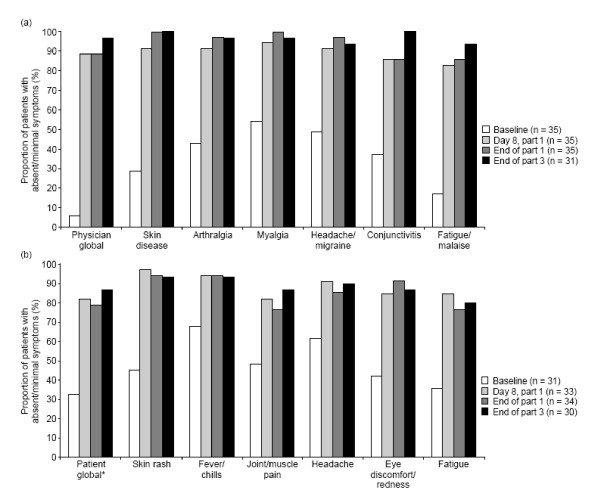
Physicians' (a) and patients' (b) assessmentsa of disease activity and individual symptoms over the study. aGlobal disease activity and symptoms were assessed by using a 5-point scale. *n = 33 for end of part 1.